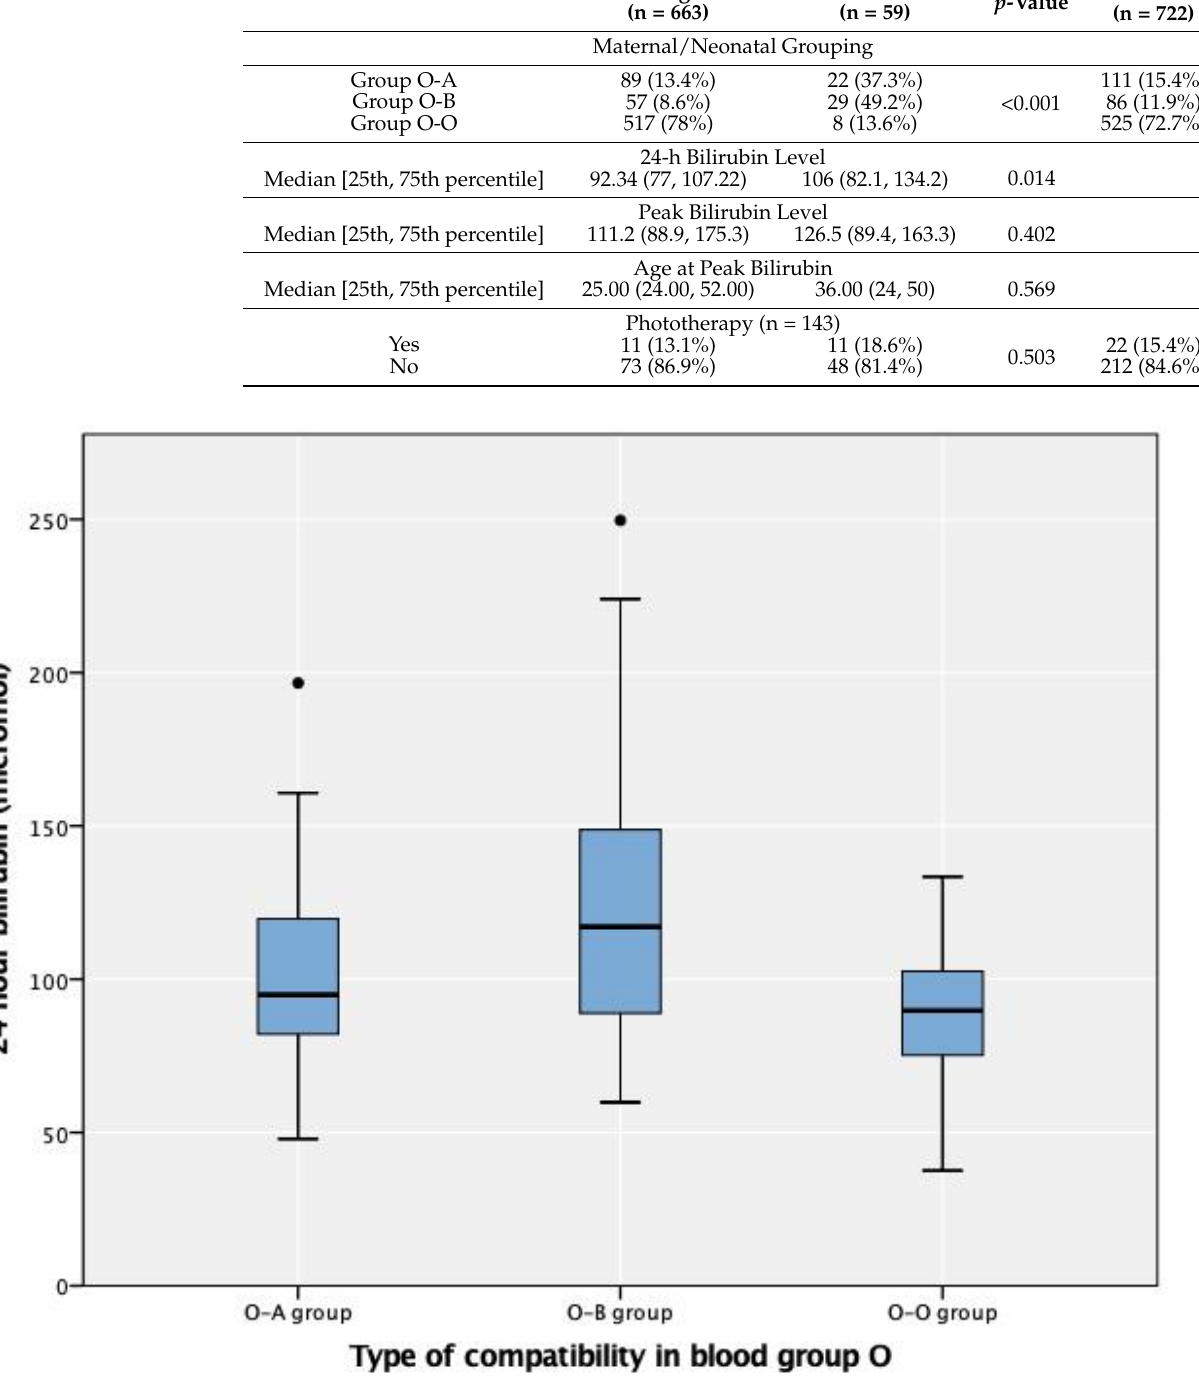
Figure 2. Twenty-four-hour bilirubin in neonates born to mothers with blood group O. The circles represent the outliers of the bilirubin levels in each type of blood group incompatibility.